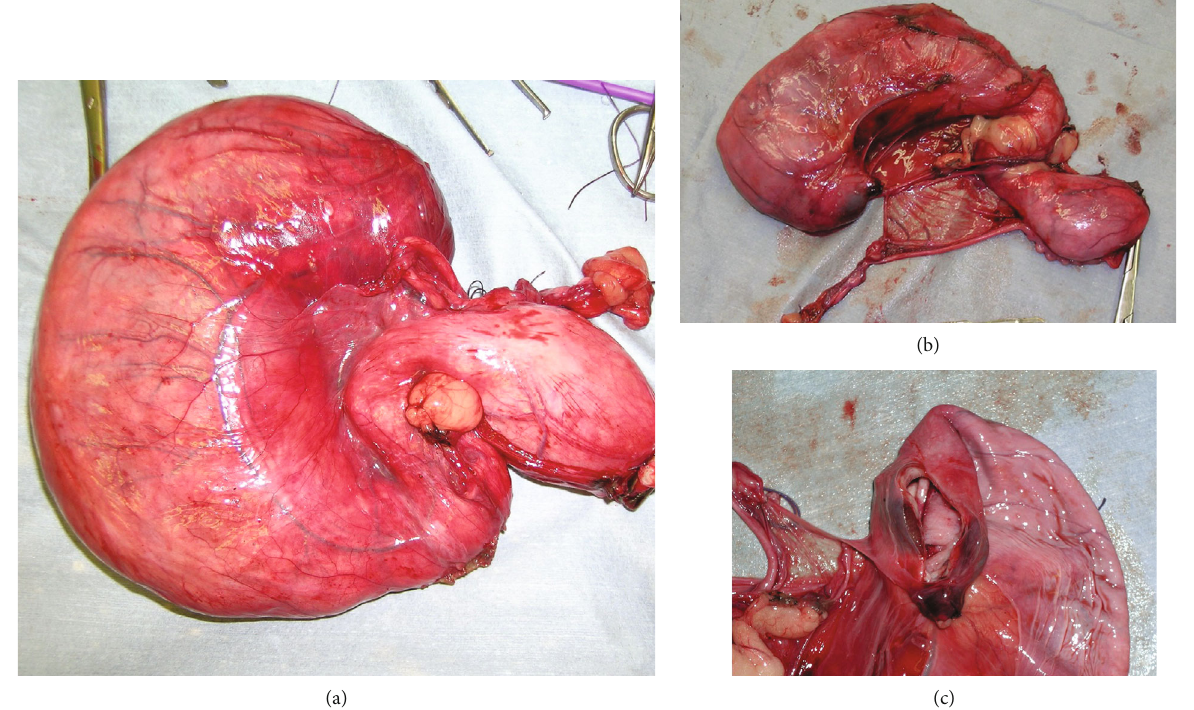
Figure 5: Complex of megaureter, renal pelvis, dysplastic kidney, vas deferens , and sketch of the genital annexes after excision: (a) ventral aspect; (b) dorsal aspect; (c) detail of the dysplastic-small kidney after sectioning and emptying the megaureter.